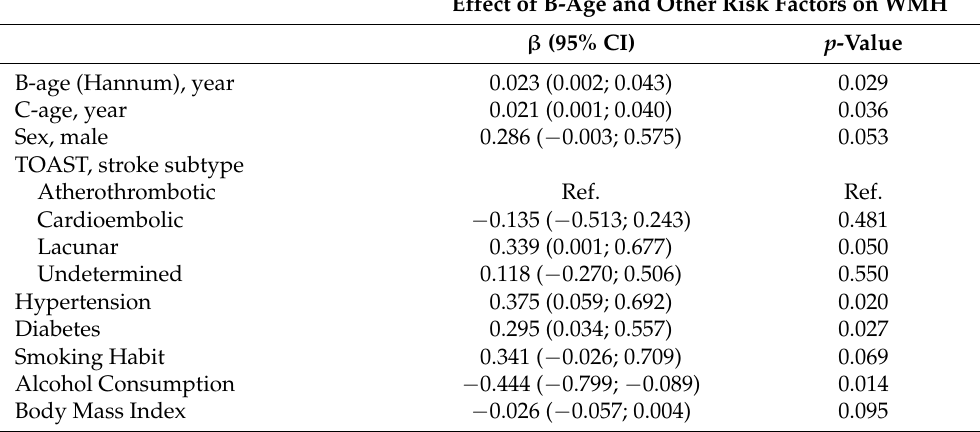
Table 3. This model was achieved after applying a forward stepwise variable selection on Model 3 from Table 2. Of note, B-age Hannum rather than B-age Horvath was included in the final model. Values represent β coefficients, 95% confidence intervals (CI) and p -values.